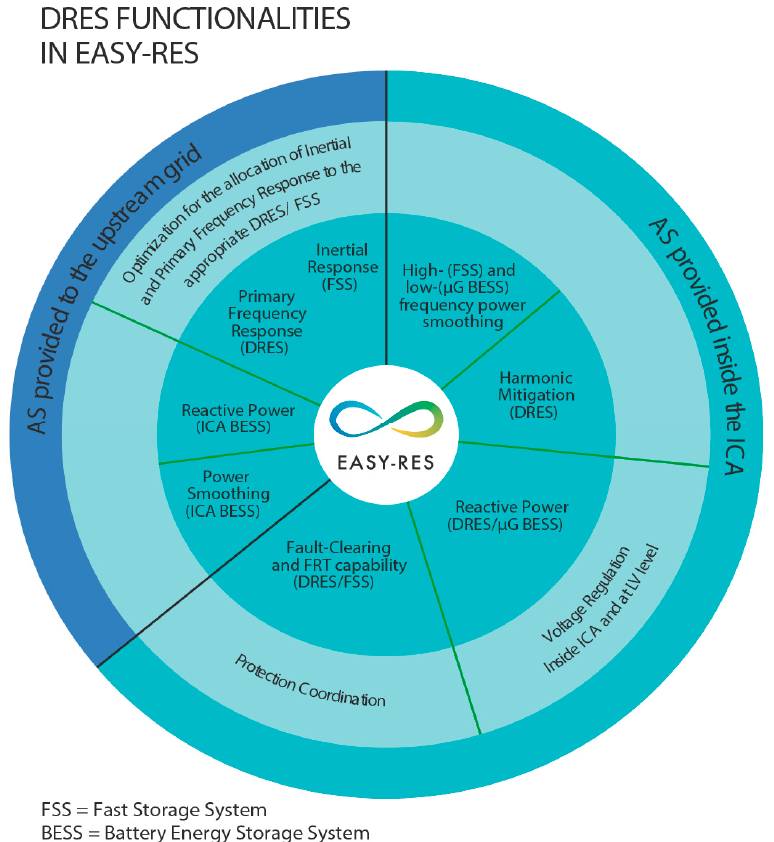
Figure 6. New ASs dealt with in the EASY-RES project [157].